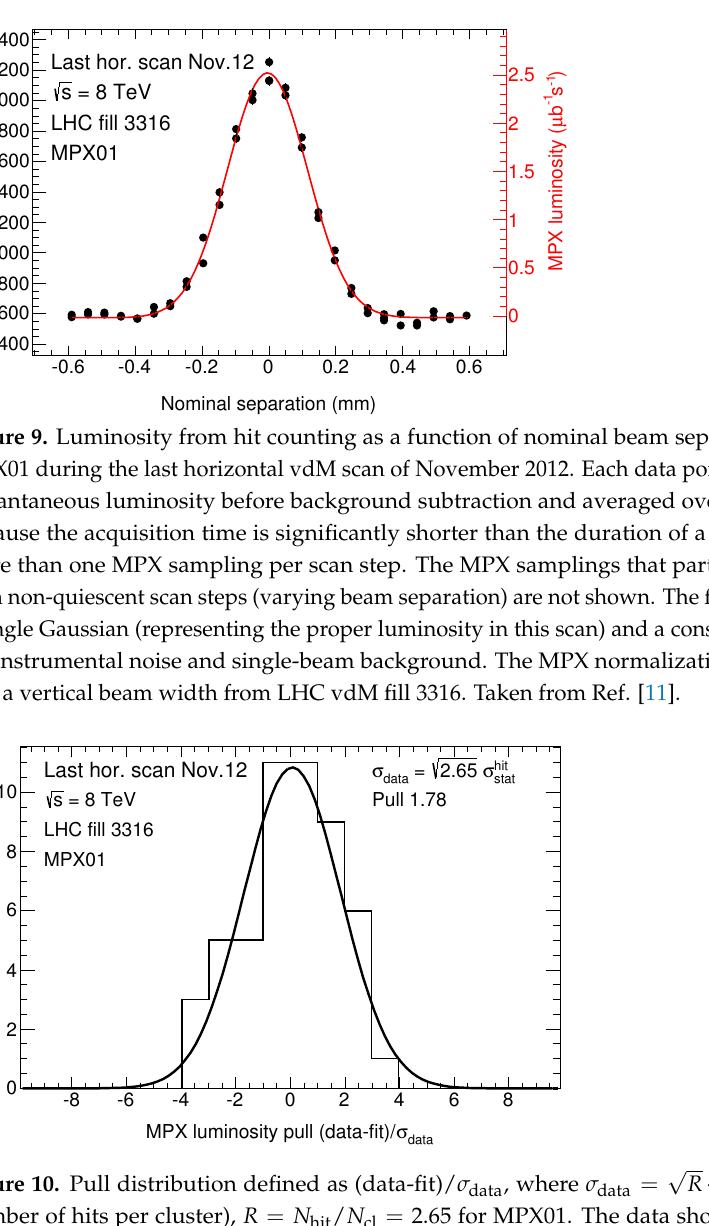
Figure 10. Pull distribution defined as (data-fit)/ σ data , where σ data = number of hits per cluster), R = N hit / N cl = 2.65 for MPX01. The data shown in Figure 9 is used. LHC fill 3316. Taken from Ref.